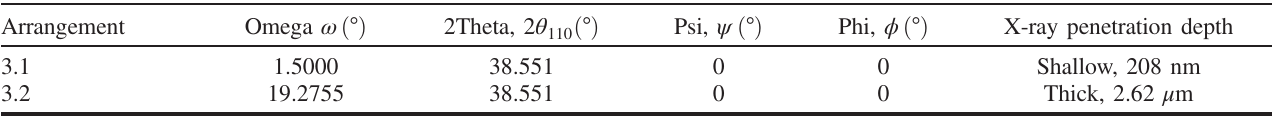
TABLE IV. Two RSM experimental arrangements to measure f 110 g reciprocal points at different x-ray penetration depth. Sample label is Nb-PC-01. It is a polycrystalline bulk Nb sample.